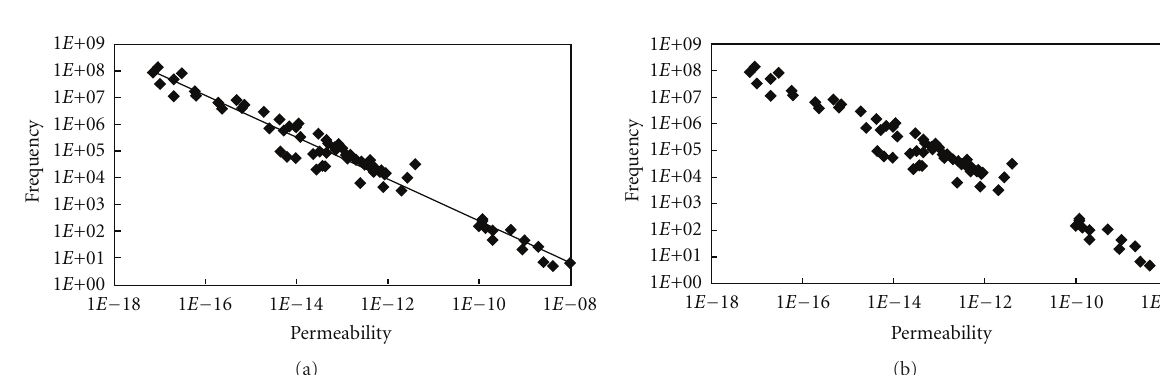
Figure 1: The transition frequency f c = ω c / 2 π (in Hz) predicted in the present study with ω c from (11) with η = 10 − 3 Pa.s and ρ f = 10 3 kg/m 3 as a function of the permeability (in m 2 ). The transition frequency varies as log samples, F and k 0 , are measured from di ff erent authors on various samples cited in Tables 1 and